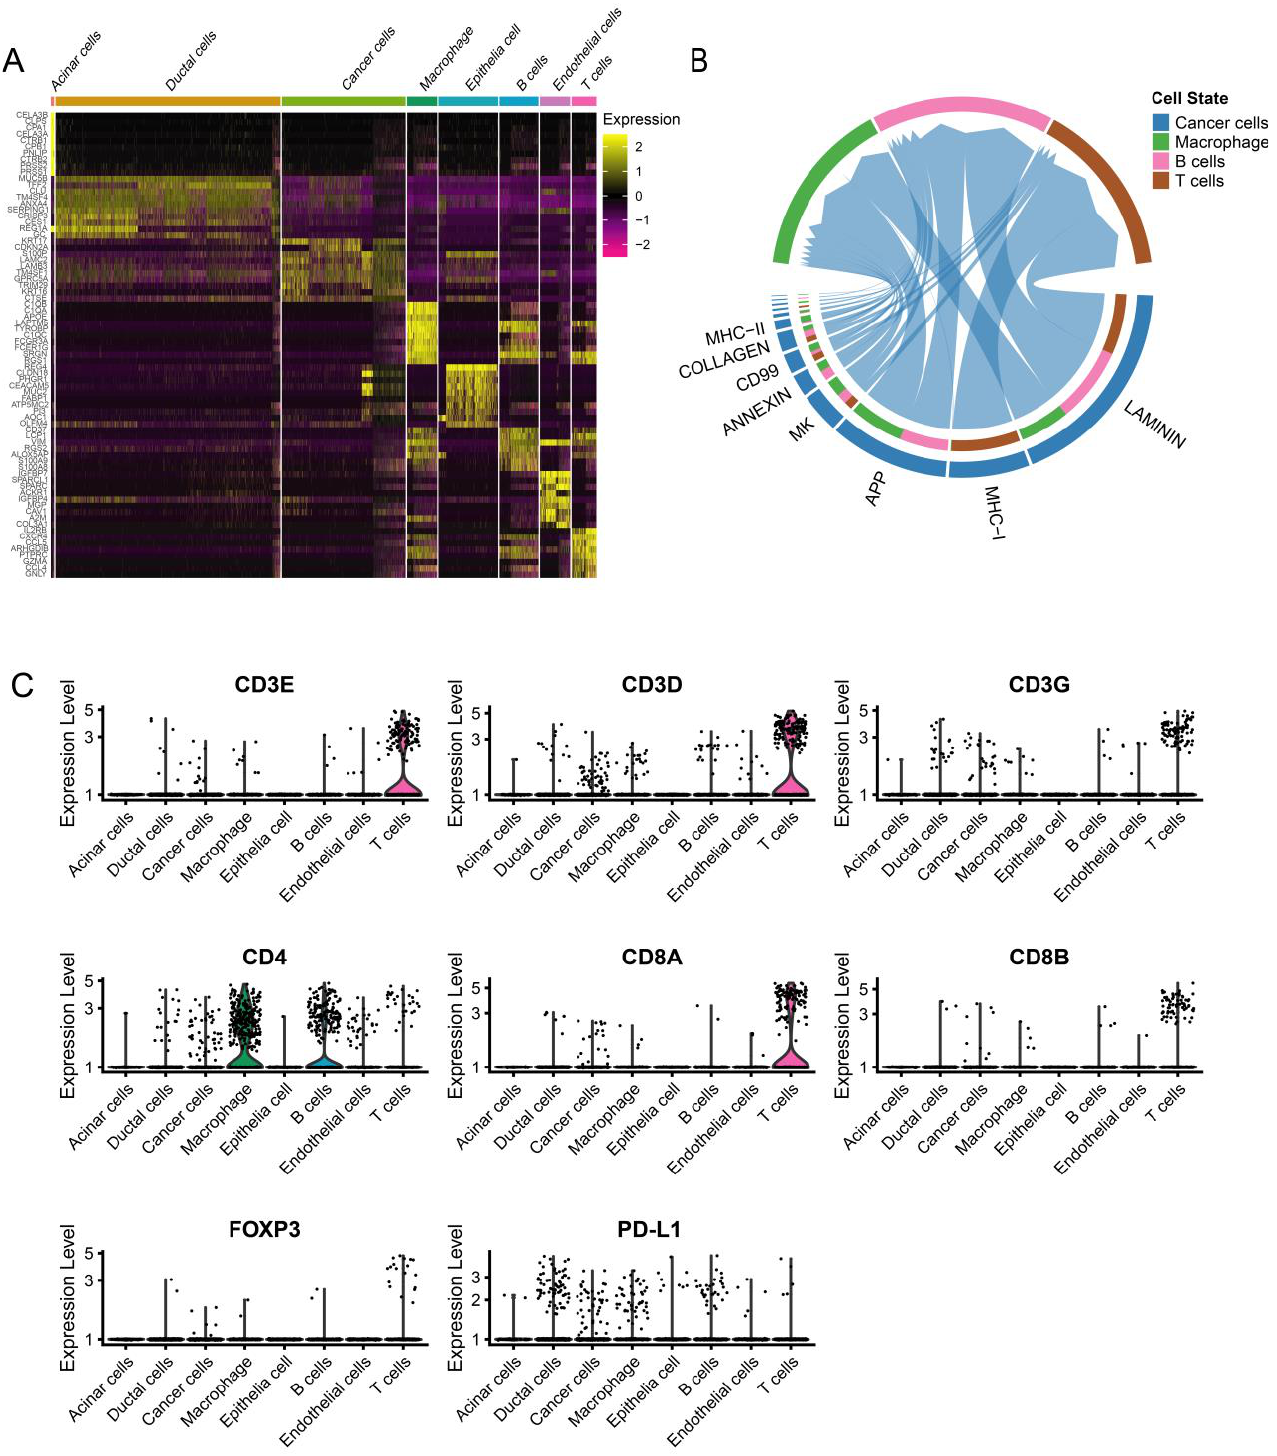
Figure 4. ScRNA-seq demonstrating specific cell subpopulations and cell communications among subgroups. ( A ) Heatmap of top ten differentially expressed genes in each cell type. ( B ) CellChat has been used to quantitively infer and analyze intercellular communication networks from scRNA-seq data. ( C ) Violin plot showing the expression of immunomarkers of eight cell clusters.